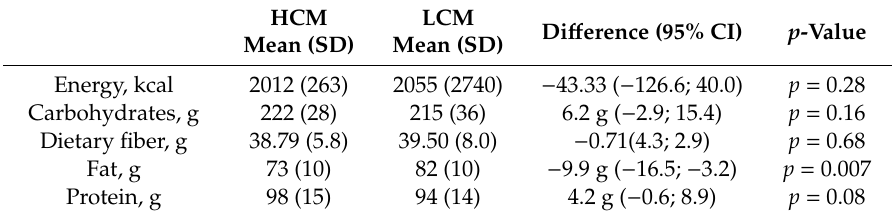
Table 6. Intra-individual comparison of food intake between HCM and